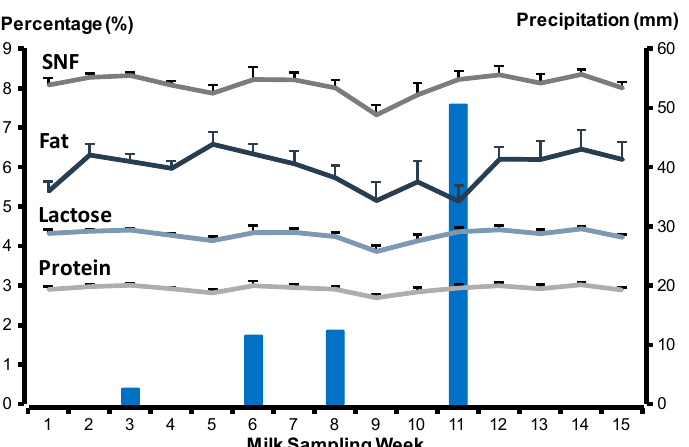
Figure 1. Milk fat, protein, lactose, and solids-non-fat (SNF) from mixed-breed non-supplemented goats reared on a Xerophytic ecosystem in northern Mexico during the dry period (winter–spring). Blue bars represent the precipitation during the study period. The grey dark line represents solids-non-fat content (±SEM), the grey light line represents milk protein content (±SEM), the blue dark line represents milk fat content (±SEM) and the blue light line represents milk lactose content (±SEM).